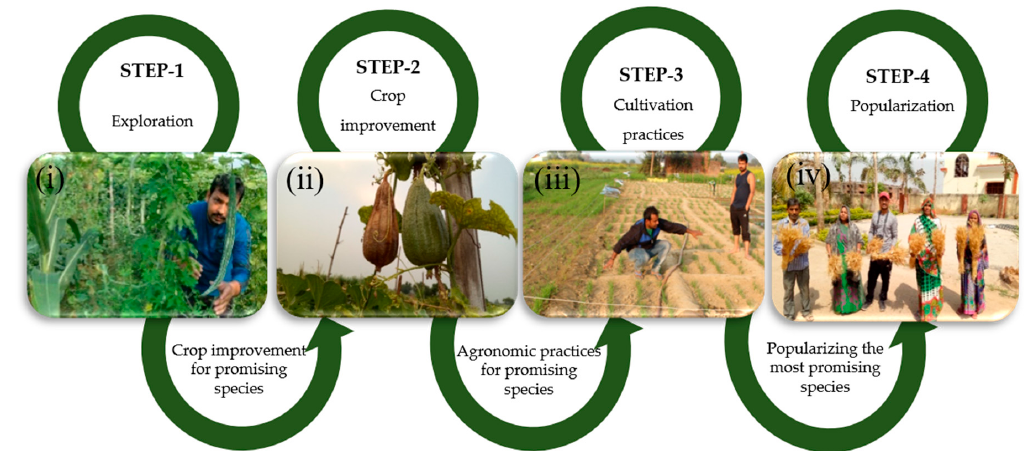
Figure 1. A casual loop diagram showing various steps involved in the sustainable utilization of wild and neglected crops for global food and nutritional security. ( i ) Step-1: exploration of various kind of wild and neglected crops; ( ii ) Step-2: improving the desirable traits in promising species by conventional as well as modern biotechnological approaches; ( iii ) Step-3: standardization and optimization of various agronomic practices for their large-scale exploitation and ( iv ) Step-4: the popularization of unpopular crops among farmers, policy makers, and other stakeholders.